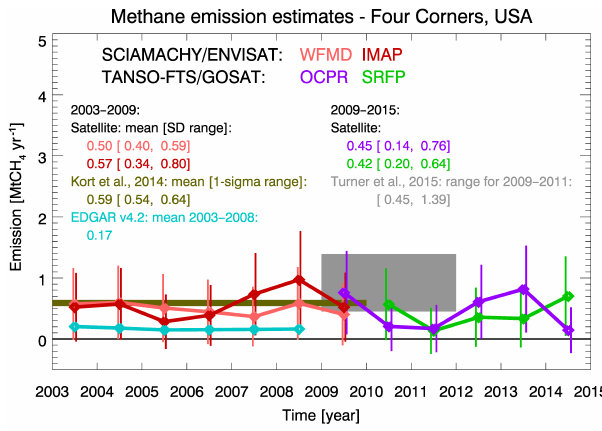
Figure 16. Methane emission estimates for Four Corners as ob- tained from the methane enhancements shown in Fig. 15. Shown here are the satellite-derived annual methane emissions and their 1 σ uncertainty as derived from the four satellite data products used in this study using the method described in Sect. 3. The listed numeri- cal values for the satellite-derived emissions are the mean value and a range defined as mean value plus/minus 1 times the standard de- viation of the annual averages. The results are compared with pub- lished values as listed in Kort et al. (2014) (for 2003–2009; shown in dark green) and Turner et al. (2015) (for 2009–2011; shown in grey). Also shown are the EDGAR v4.2 total anthropogenic emis- sions during 2003–2008 (in light blue). It needs to be pointed out that the estimated emissions using satellite data are total methane emissions, whereas EDGAR is (only)